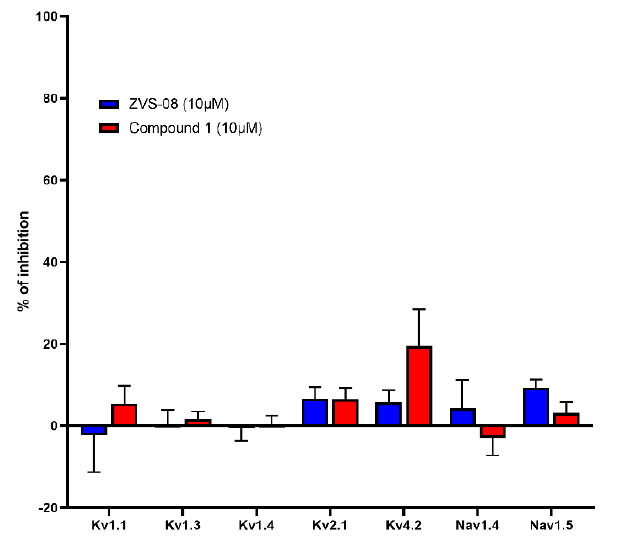
Figure 13. Selectivity screening of ZVS-08 and 1 against voltage-gated potassium and sodium channels at a concentration of 10 µM. Data were obtained with the two-electrode voltage clamp on Xenopus laevis oocytes. Data are presented as means ± SEM of n ≥ 3 independent experiments.